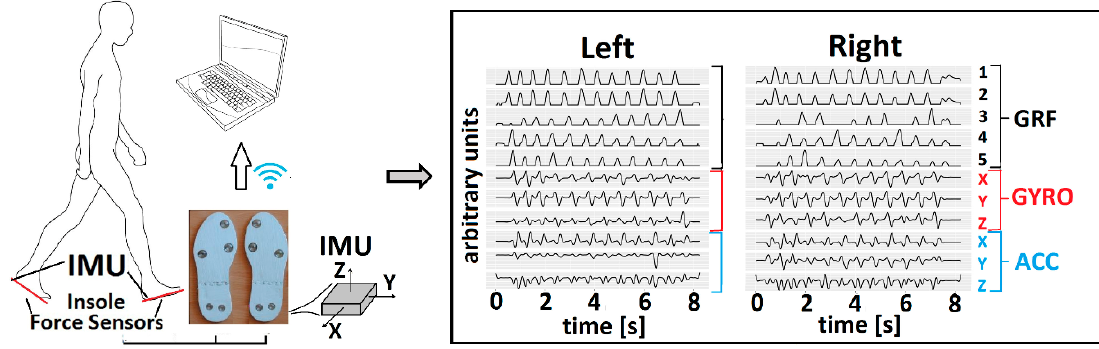
Figure 1. Gait Teacher instrumentation and output signals from both insoles.